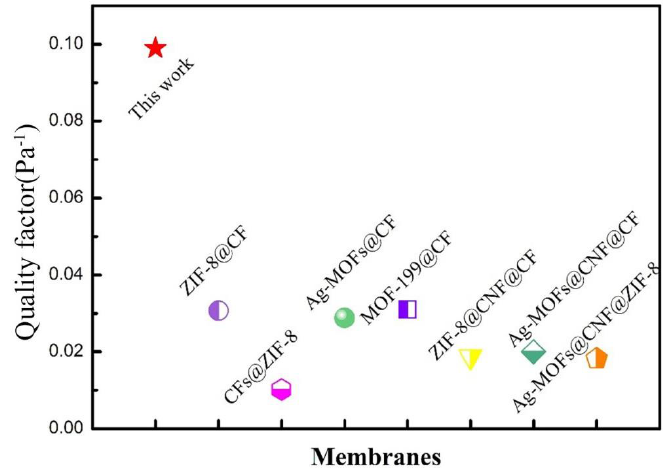
Figure 9. Quality factor of PP/PVA/ZIF-8-2.5 % melt-blown electrospun composite membranes and other air filters.